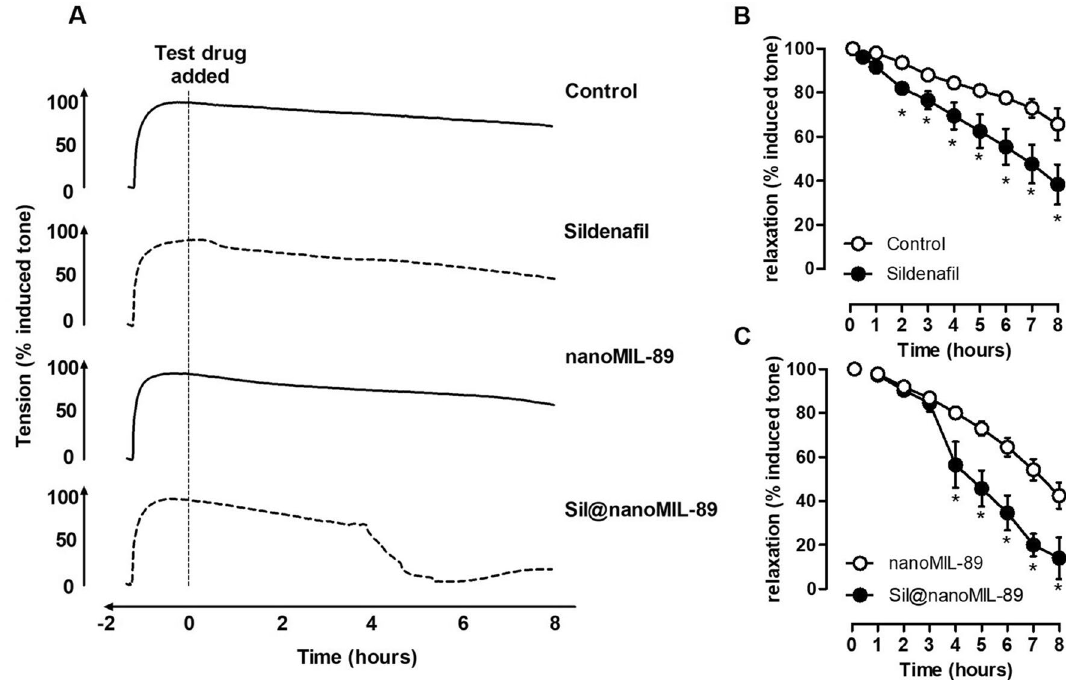
Figure 5. Vasodilator effects of sildenafil (10 µM), nanoMIL-89 (10 µg/ml), and Sil@nanoMIL-89 (10 µg/ml) on pre-contracted mouse aorta. The figure shows representative vessel responses across the full-time course ( A ) and pooled data presented as mean ± SEM for n = 3–8 vessels from 3–4 mice ( B , C ). Statistical significance was determined by two-way ANOVA followed by Tukey’s multiple comparisons test. Statistical significance was assumed where *P <